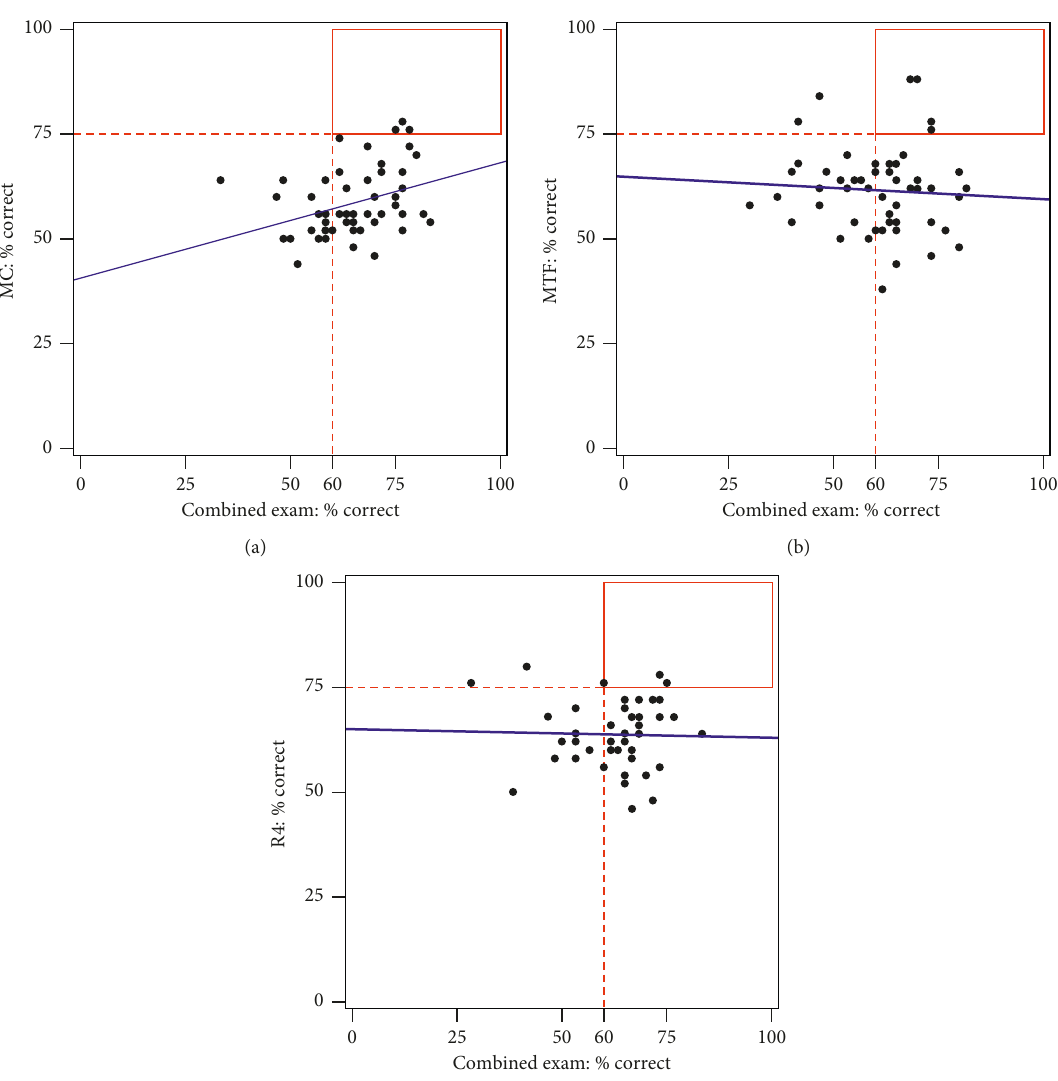
Figure 5: Performance of the year 2013 students. Performance of the 2013 MC group (panel (a)), MTF group (panel (b)), and R4 group (panel (c)) in the combined regular exams versus their performance in the additional questions. Each dot represents the scores of a single examinee with dots in the upper right rectangle being the ones that passed both exams. Dotted lines indicate scores required for passing. The straight line represents the linear fit to the data.